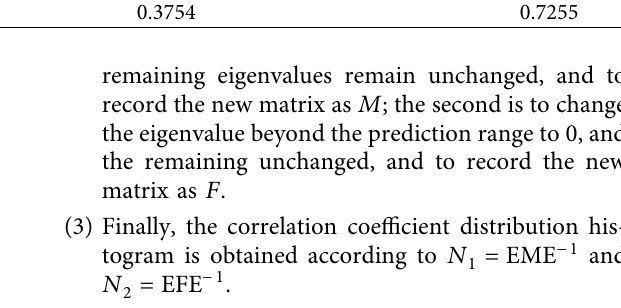
Figure 3: Comparison of eigenvalue density distributions of empirical correlation matrix and the random correlation matrix. Table 3: Comparison of eigenvalue entropies between an empirical correlation matrix and a random matrix under diferent conditions. Empirical matrix Random matrix Eigenvalue entropy with the max-eigenvalue 0.0392 0.7592 Eigenvalue entropy without the max-eigenvalue 0.2459